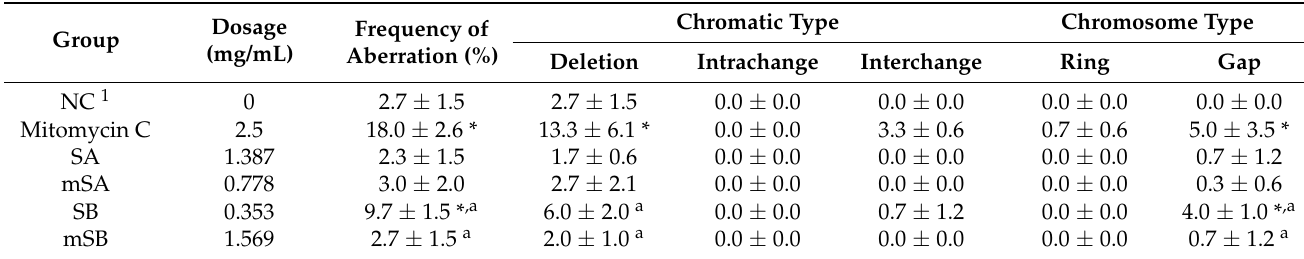
Table 6. Frequency of chromosomal aberration without S9 metabolism of unmodified and modified nano-silica in CHO- K1 cells.